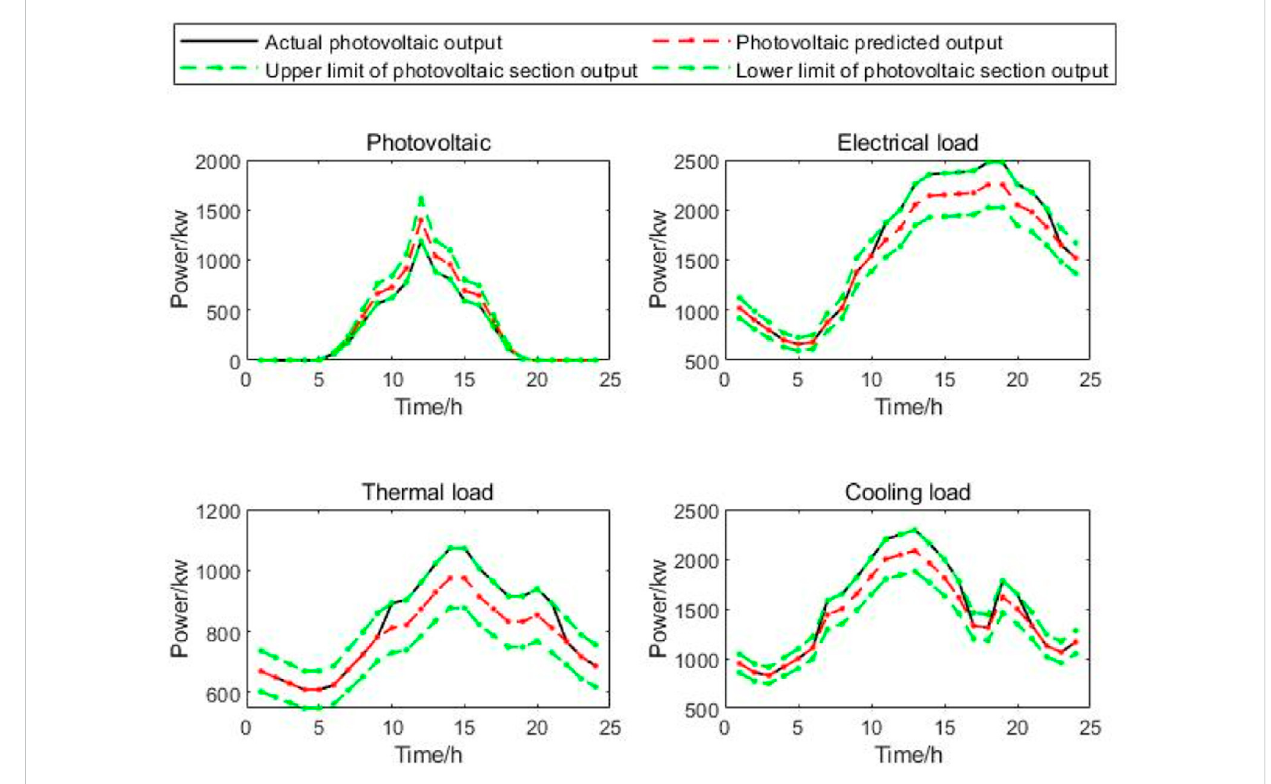
FIGURE 12 Uncertain parameters in the worst case for Γ (cid:1) 12.